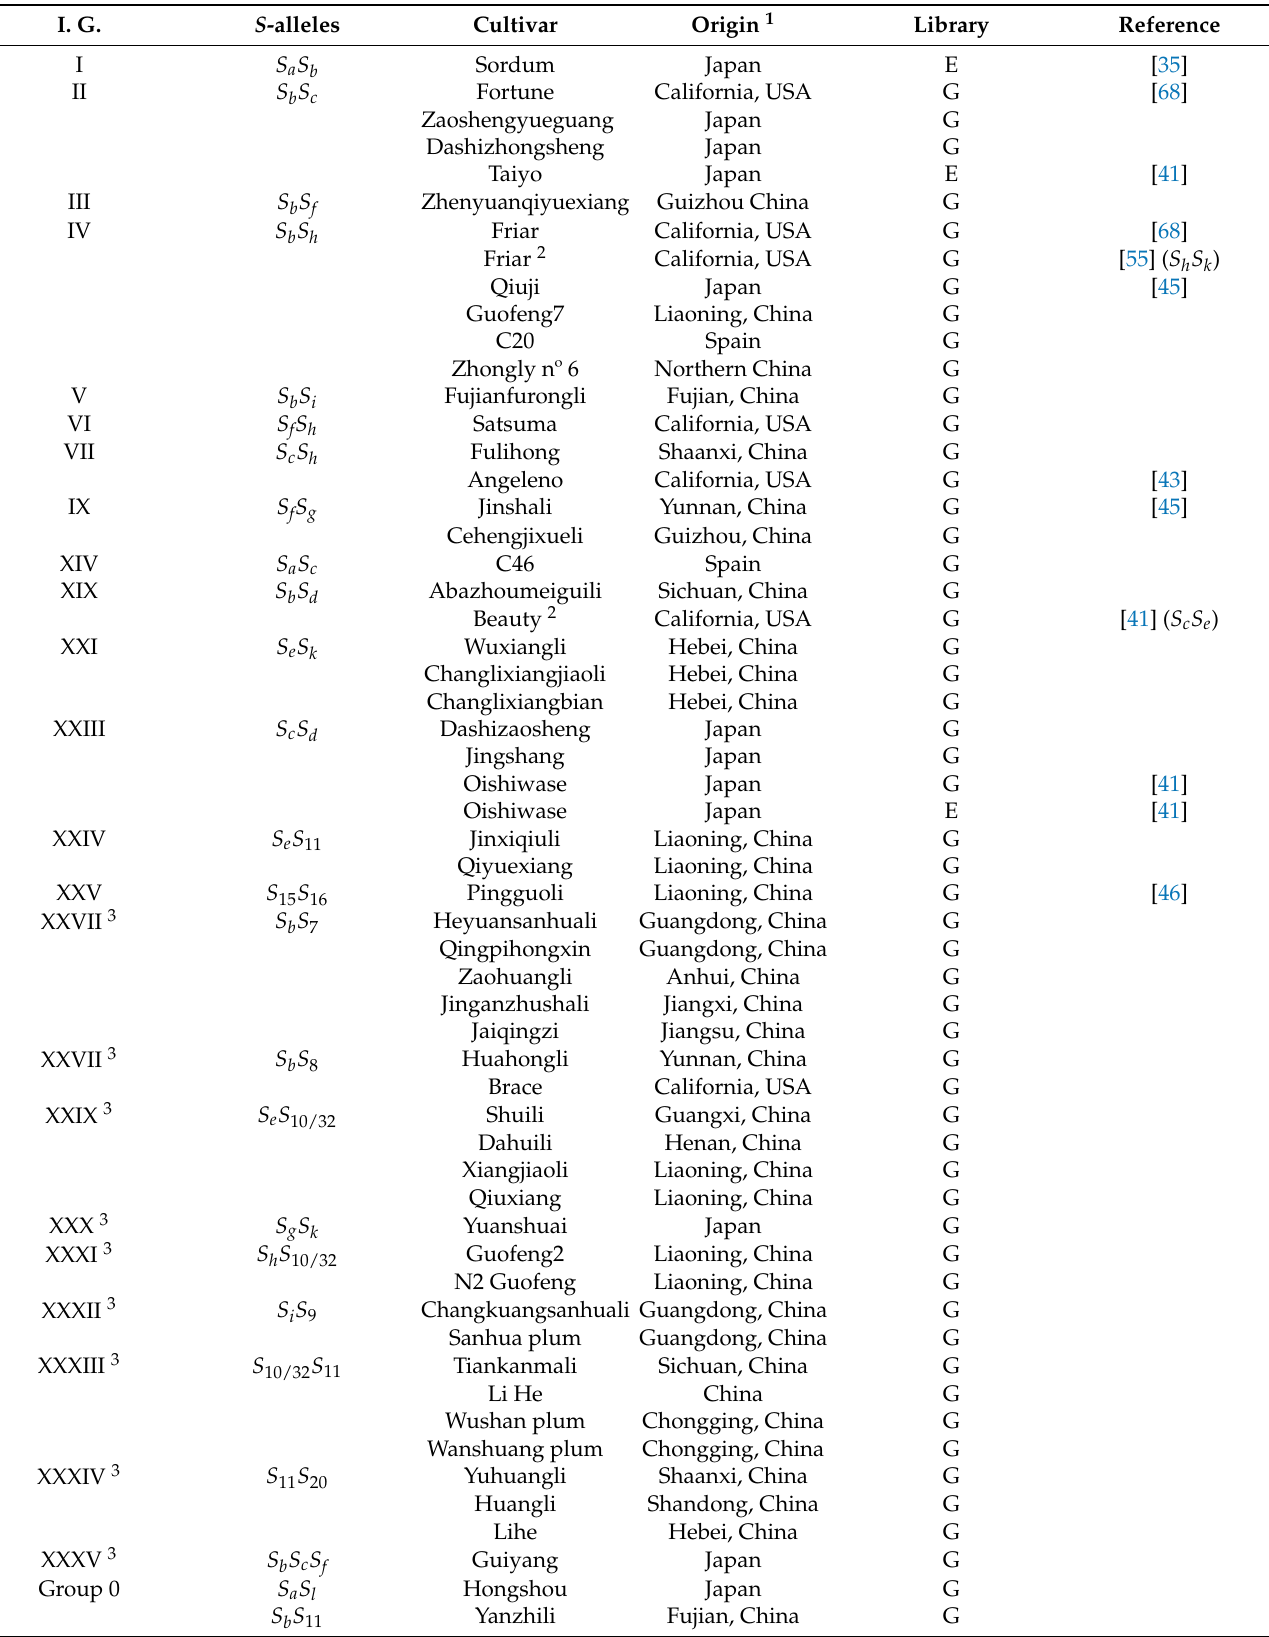
Table 2. Incompatibility groups (I. G.), S -genotype and library type (E: exon-targeted capture, G: genomic, T: transcriptome) of 88 Japanese plum